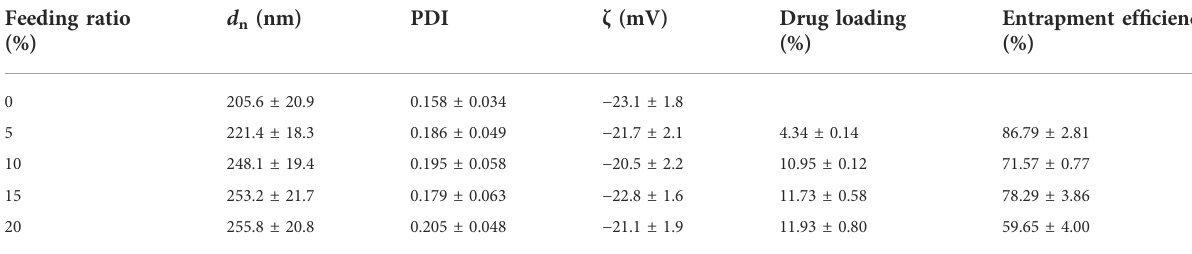
TABLE 1 Characterization of VCAM@TPP-MLT NLCs with different feeding ratios of TPP-MLT. Feeding ratio